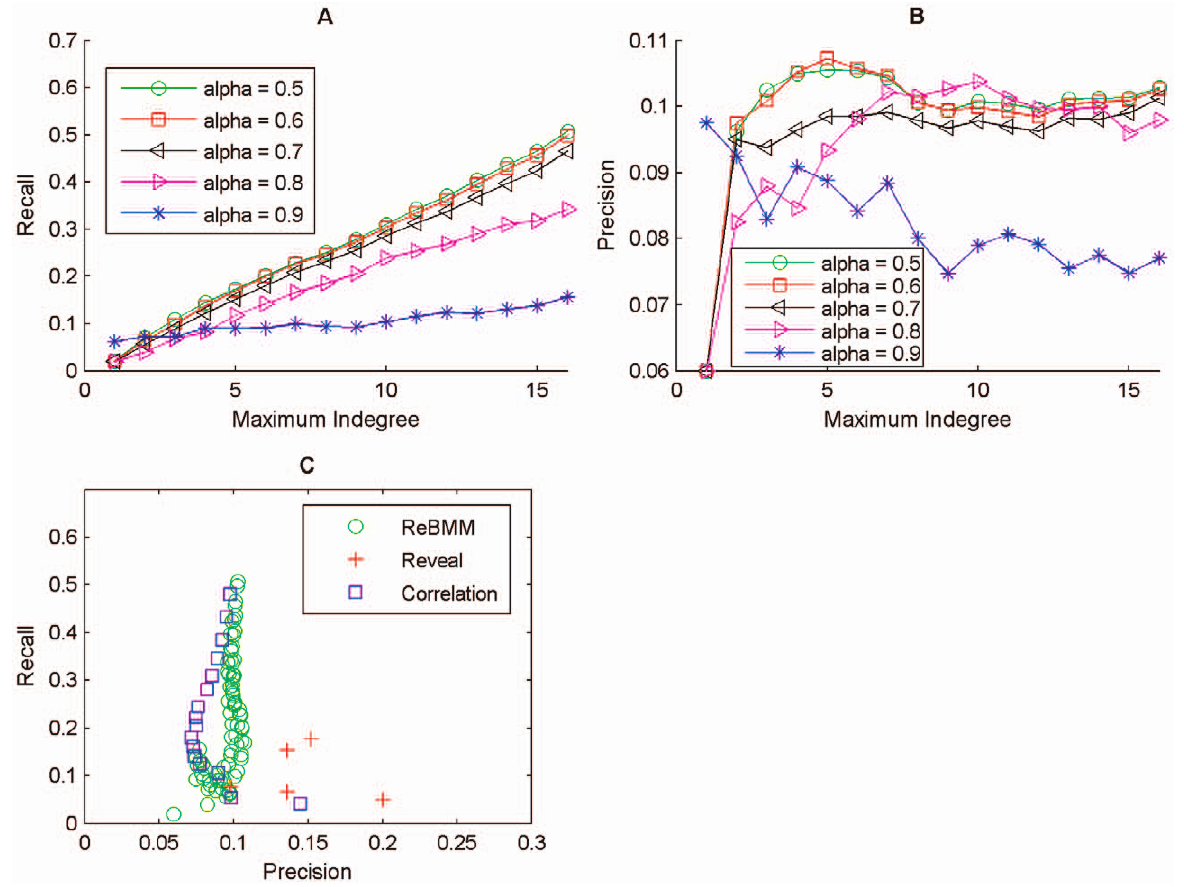
Figure 10. Reconstruction of network for the cdc15 experiments of the yeast cell cycle microarray data. Figure A shows the recall against maximum indegree for ReBMM for different threshold values, a . Figure B illustrates the plot for precision. The comparison of ReBMM, correlation and REVEAL is displayed in Figure C. Clearly the performance of ReBMM is better than the other two methods in terms of precision. REVEAL has the highest precision but the recall is very low.